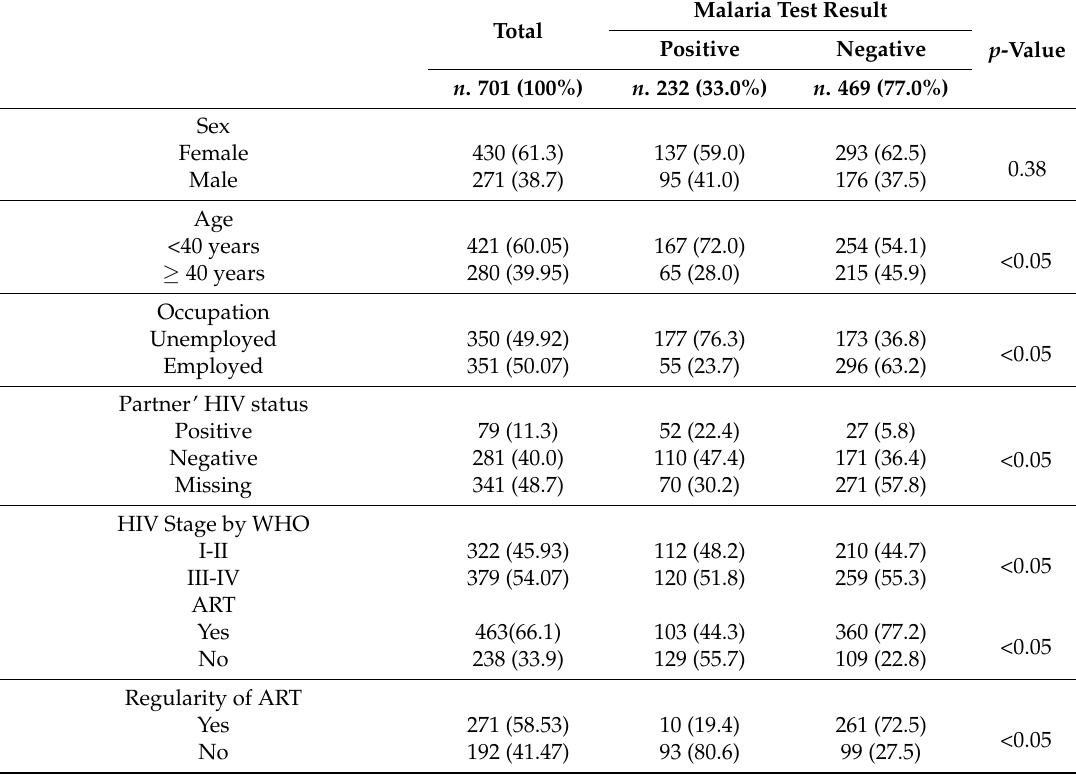
Table 1. Demographic and HIV related characteristics of 701 HIV positive patients, stratified by malaria test